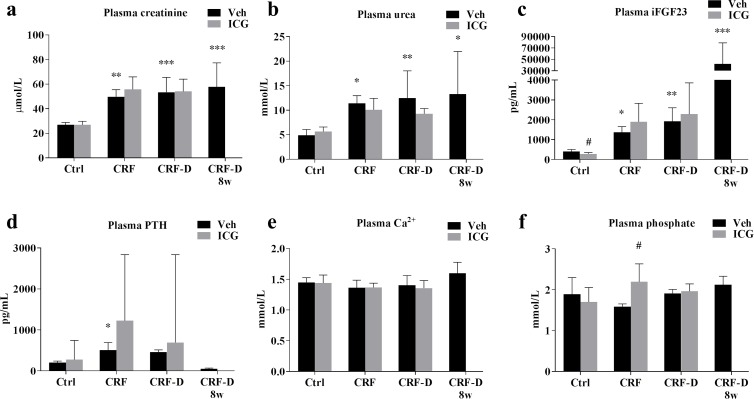
Plasma biochemistry.Plasma levels of (a) creatinine, (b) urea, (c) intact fibroblast growth factor 23 (iFGF23), (d) PTH, (e) Ca2+ and (f) phosphate measured at sacrifice. CRF and CRF-D rats had a mild to moderate reduction in kidney function with increased levels of plasma creatinine, urea, iFGF23 and PTH. In the CRF-D rats sacrificed at 8 weeks the iFGF23 levels were extremely elevated, PTH was suppressed, and a trend towards an increase in Ca2+ was seen. iFGF23 levels were slightly lower in ICG-001-administered Ctrl compared to vehicle-administered Ctrl and plasma phosphate was markedly higher in the ICG-001-administered CRF compared to the vehicle-administered CRF. Data is presented as mean ± SD, and PTH as median and interquartile range. n = 6–9. Vehicle-administered Ctrl, CRF and CRF-D rats were compared by one-way ANOVA and Dunnets multiple comparison with *P<0.05, **P<0.001 and ***P<0.0001 vs Ctrl. ICG-001- and vehicle-administered groups were compared using two-tailed t-test with #P <0.05 vs vehicle.